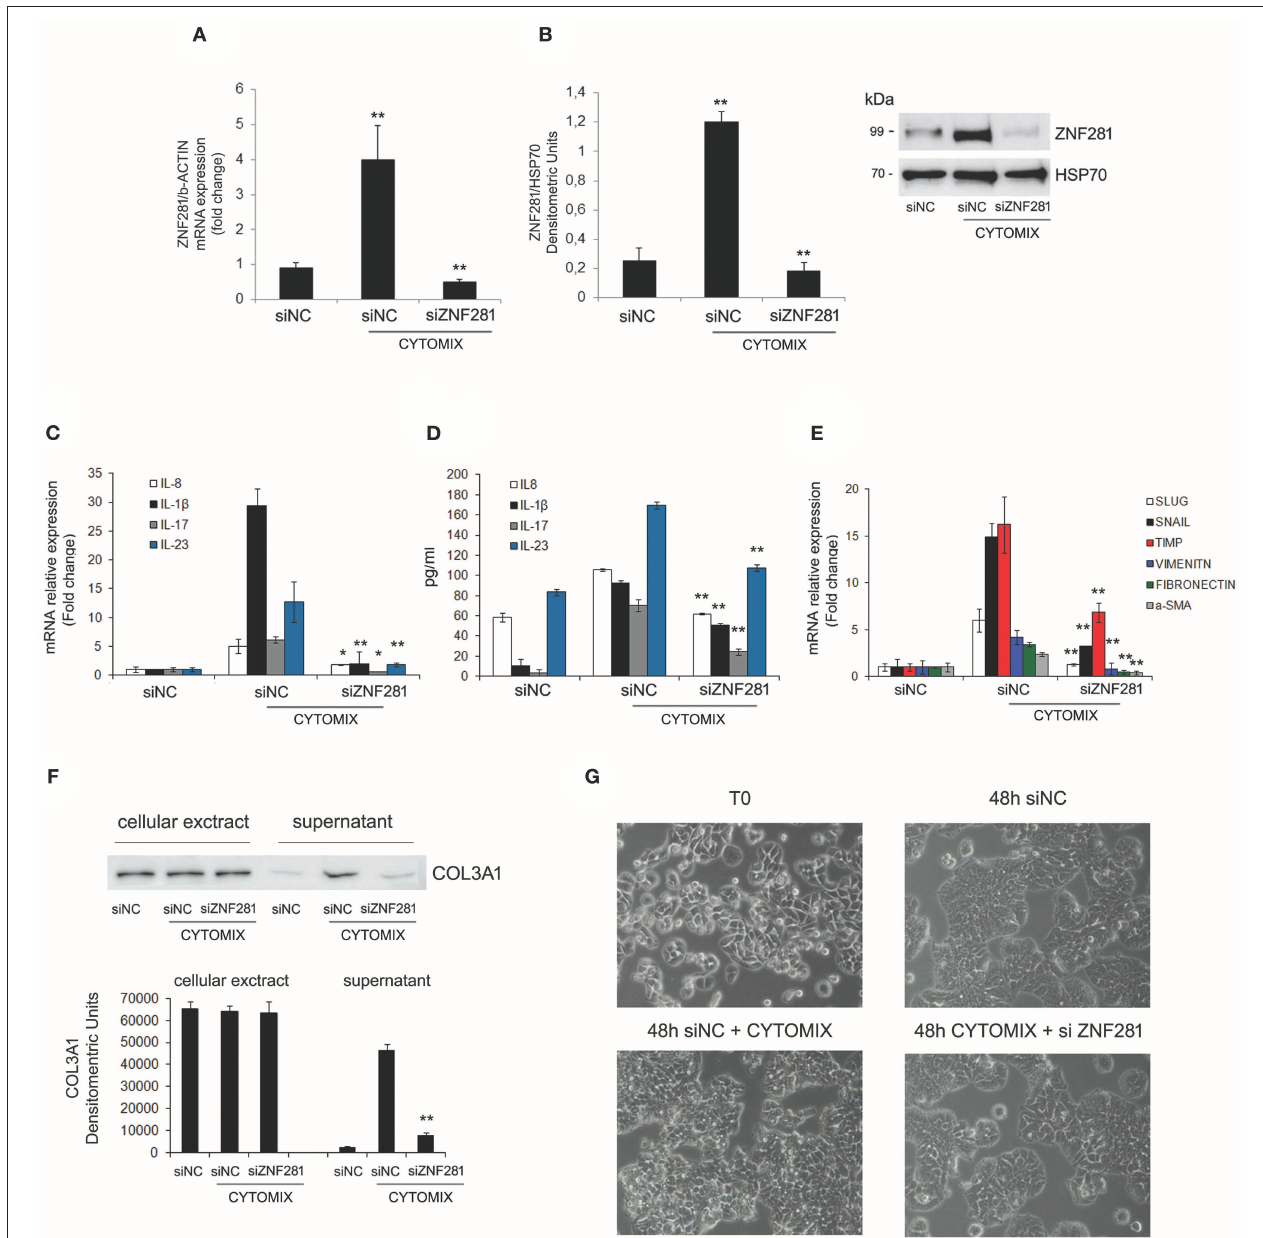
FIGURE 3 | Exposure to cytomix (TNFalpha + IFNgamma) significantly increases mRNA (A) and protein (B) ZNF281 expression, that is strongly reduced after silencing; mRNA (C) and protein (D) expression of pro-inflammatory cytokines and mRNA expression (E) of EMT/pro-fibrotic genes are significantly decreased by ZNF281 knocking down. Western blot of cellular extracts and supernatants indicate that ZNF281 silencing in HT29 cells reduces the extracellular-collagen (COL3A1) deposition previously induced by 48h of exposure to cytomix (F) . Optic microscopy images of changes in HT29 cell morphology after ZNF281 silencing (G) . Cytomix (TNFalpha + IFNgamma); siNC, negative control siRNA; siZNF281, ZNF281 targeted by small interference RNA. Mann–Whitney t -test. * P < 0.05; ** P < 0.01; *** P < 0.001.